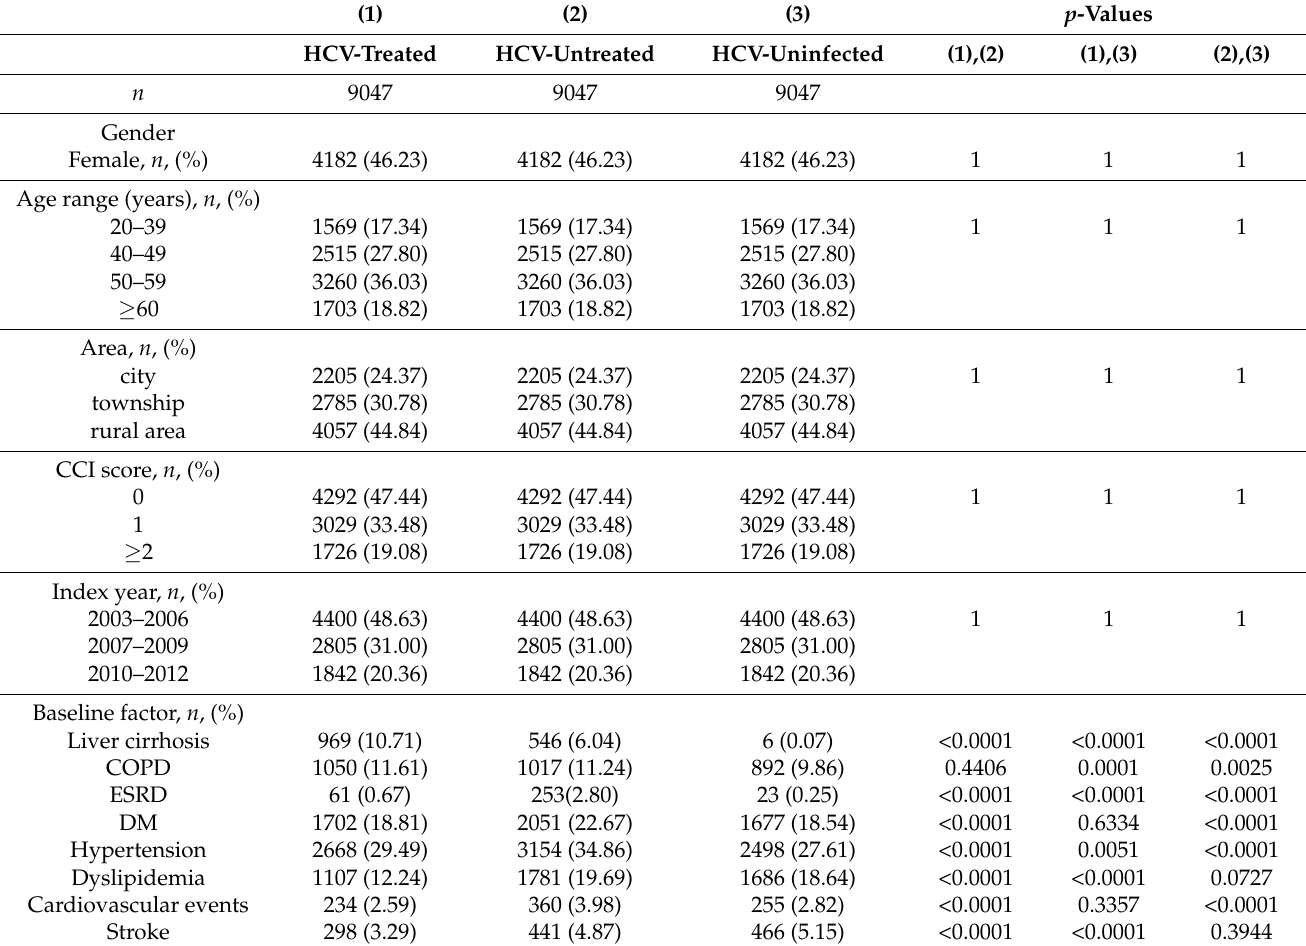
Table 1. Baseline characteristics of the 3 HCV cohorts of